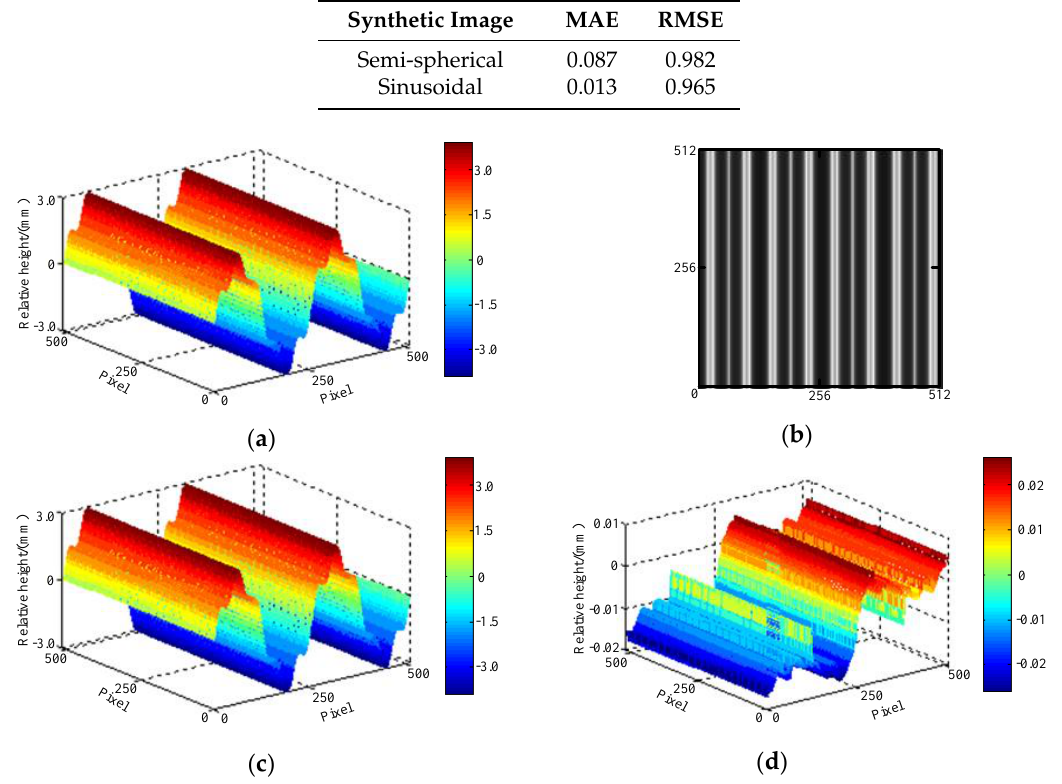
Table 1. The comparison results. MAE: mean absolute error, RMSE: root mean square error.